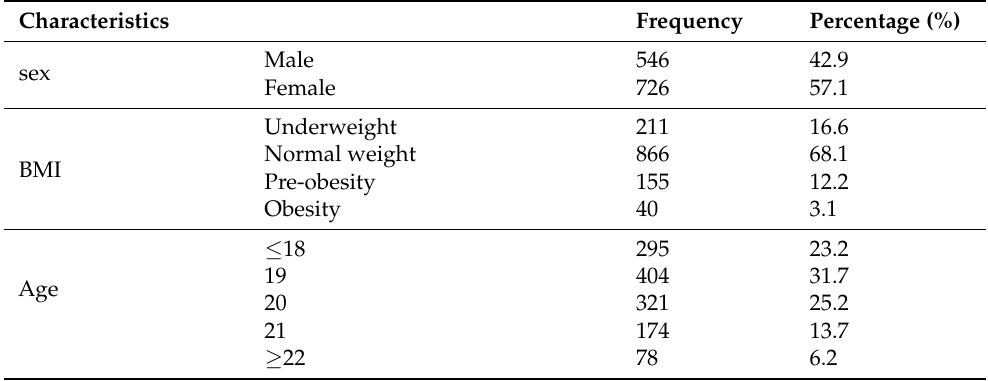
Table 1. Characteristics of respondents regarding demographics, dietary habits and anxiety ( n = 1272).